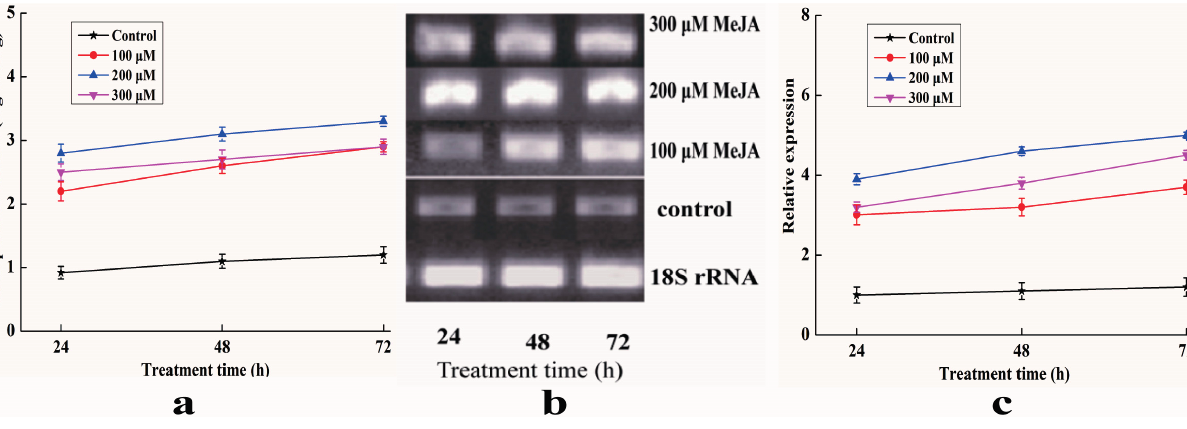
Figure 9. ( a ) Effects of different MeJA concentrations on the content of total triterpenoids in P. cocos ; ( b ) RT-PCR analysis of expression level of Pc-fps treated with different concentrations of MeJA; ( c ) Real-time quantitative PCR analysis of expression level of Pc-fps treated with different concentrations of